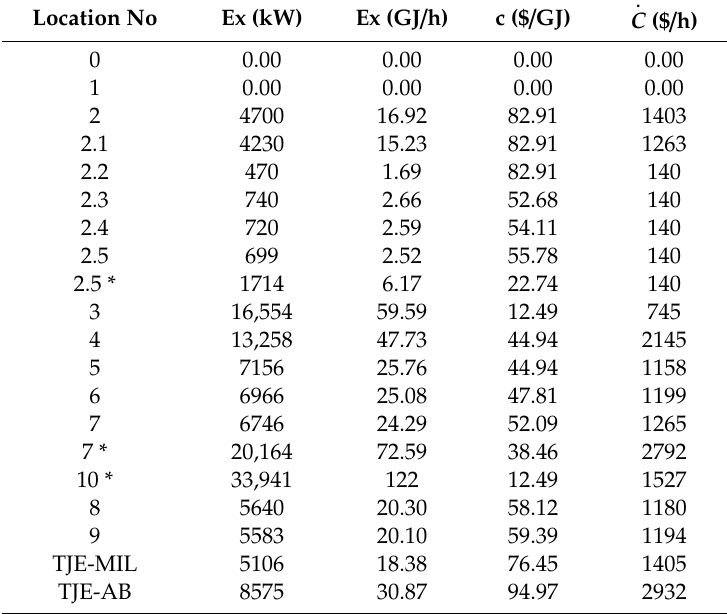
Table 6. Values for the cost rates of exergy flow and unit exergy related to process sections for kerosene fuel use (*: exclusively AB